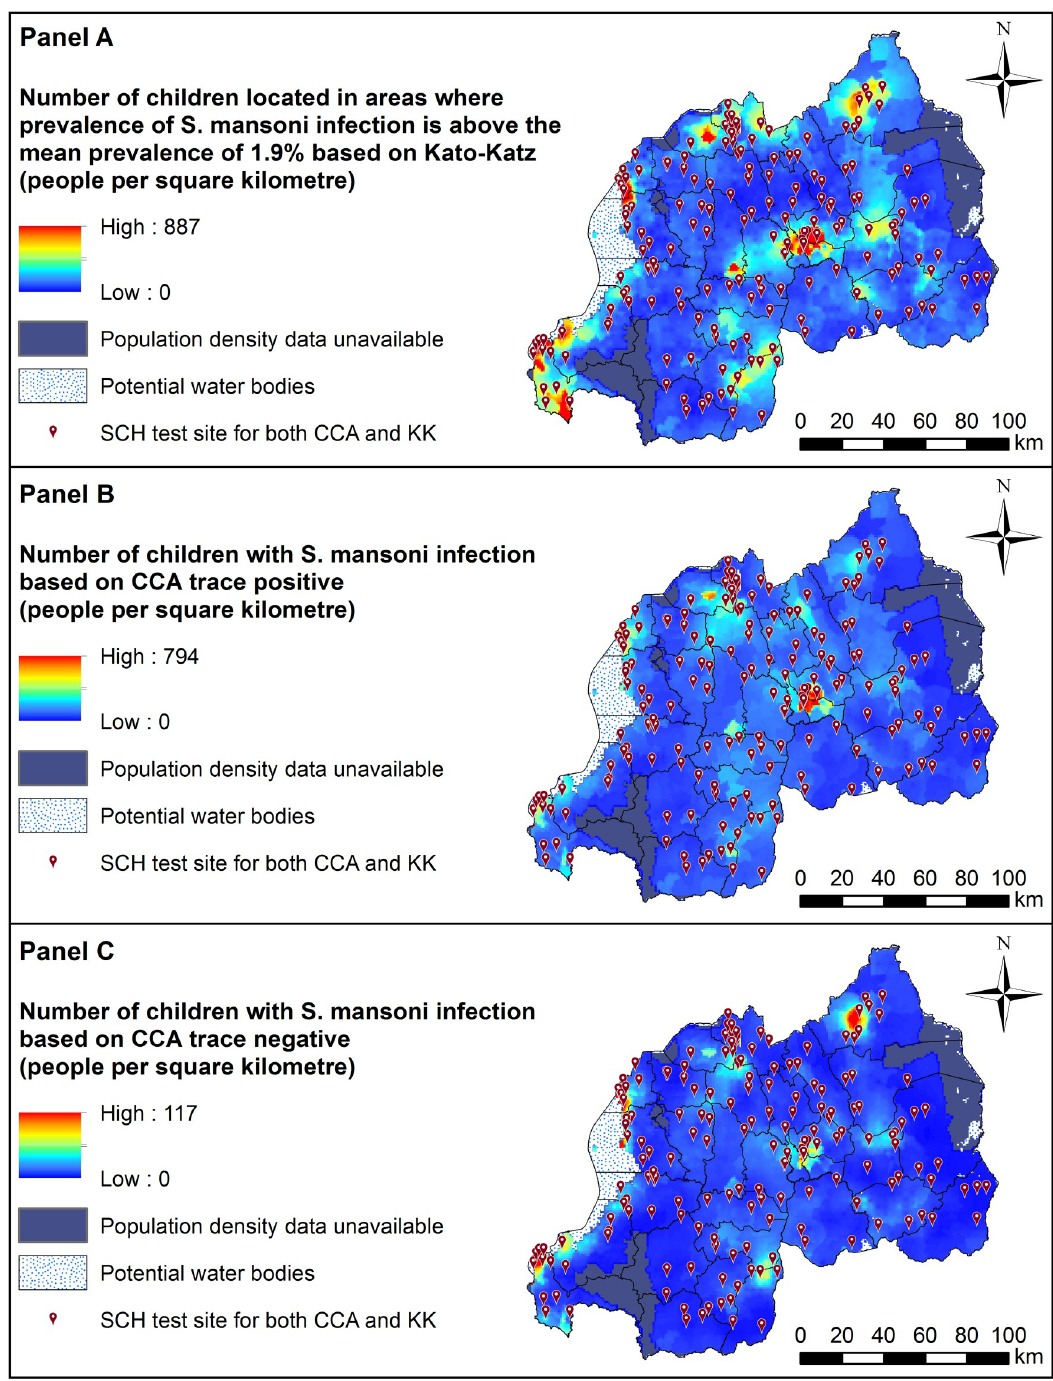
Fig 3. Distributions of the number of Rwandan boys aged 5–9 years (per square kilometre) estimated to be infected with Schistosoma mansoni based on results from three different diagnostic methods: Kato-Katz (Panel A), CCA with trace as positive (Panel B) and CCA with trace as negative (Panel C). Estimates were generated using geostatistical predictions applied to a map of Rwanda’s 2018 population. This raster was generated by multiplying National Institute of Statistics Rwanda, Fourth Population and Housing Census 2012 data [51, 52] by the reported United Nations Development Programme (UNDP) average annual rate of population change (i.e. 2.53%), which was then multiplied by the proportion of 5–9 year olds. Refer to S3 Fig in Supporting Information for names of geographical districts. This figure was produced in ArcMap 10.4 (ESRI, Redlands, CA) using a shapefile representing Rwanda’s current administrative units (obtained from the geographic data warehouse DIVA GIS (www.diva-gis.org/ Data)). CCA; Circulating Cathodic Antigen. SCH; Schistosoma prevalence mapping unit.